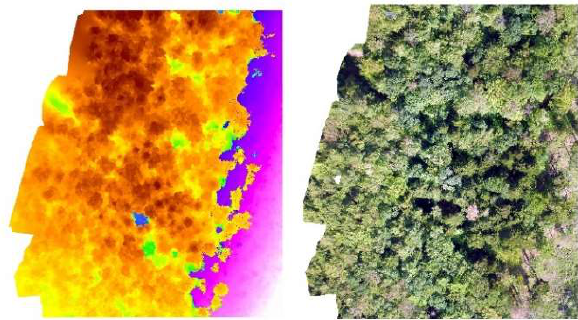
Figure 3. Inputs of software Agisoft Photoscan – DSM and ortophotomosaic from Plot 1